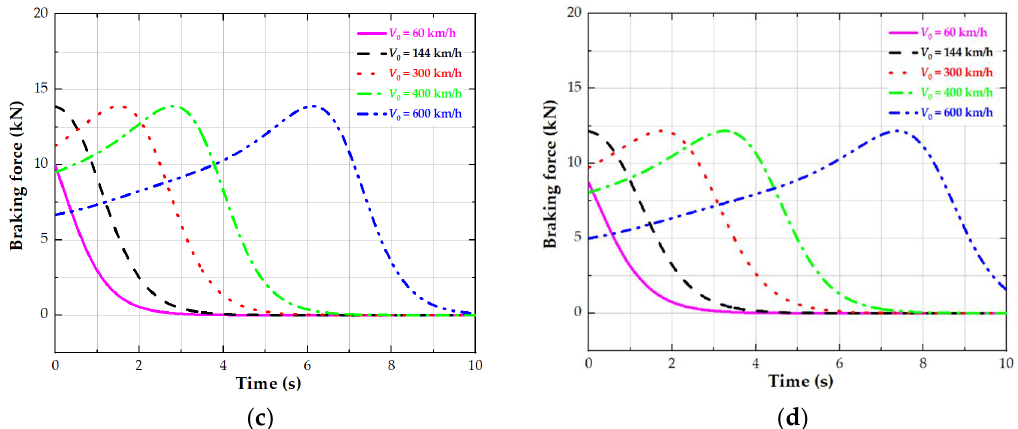
Figure 8. The change process of braking force of single PMECB at initial speeds of V 0 = 60 km/h, 144 km/h, 300 km/h, 400 km/h and 600 km/h under different air gaps: ( a ) under 5 mm air gap, ( b ) under 10 mm air gap, ( c ) under 15 mm air gap, ( d ) under 20 mm air gap.